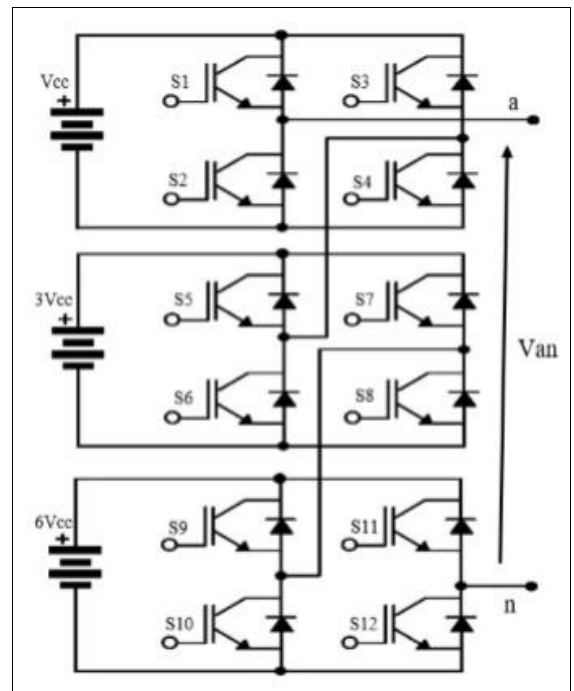
Figure 5: Multilevel inverter with three H-bridges and asymmetric sources. Source: